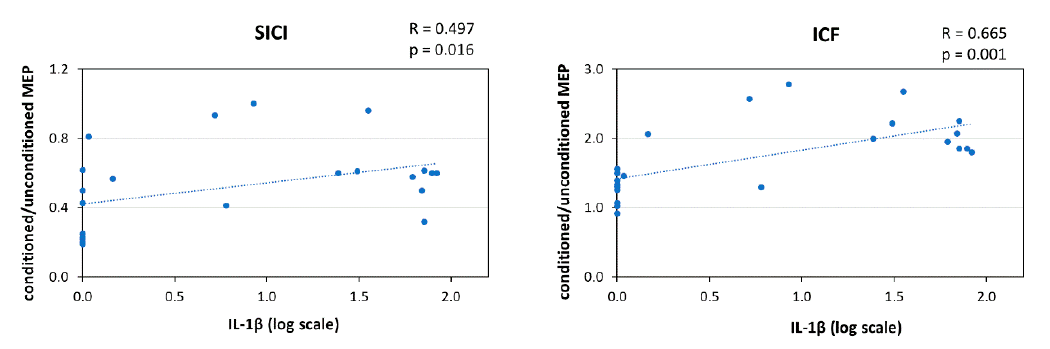
Figure 4. Correlation between IL-1 β CSF Levels and Inhibitory / Excitatory Intracortical Transmission. Figure 4 legend. IL-1 β CSF levels positively correlated with reduced intracortical inhibition ( left panel ) and increased intracortical facilitation ( right panel ). Abbreviations: CSF (cerebrospinal fluid); ICF (intracortical facilitation); IL (interleukin); MEP (motor-evoked potential); SICI (short-interval intracortical inhibition).